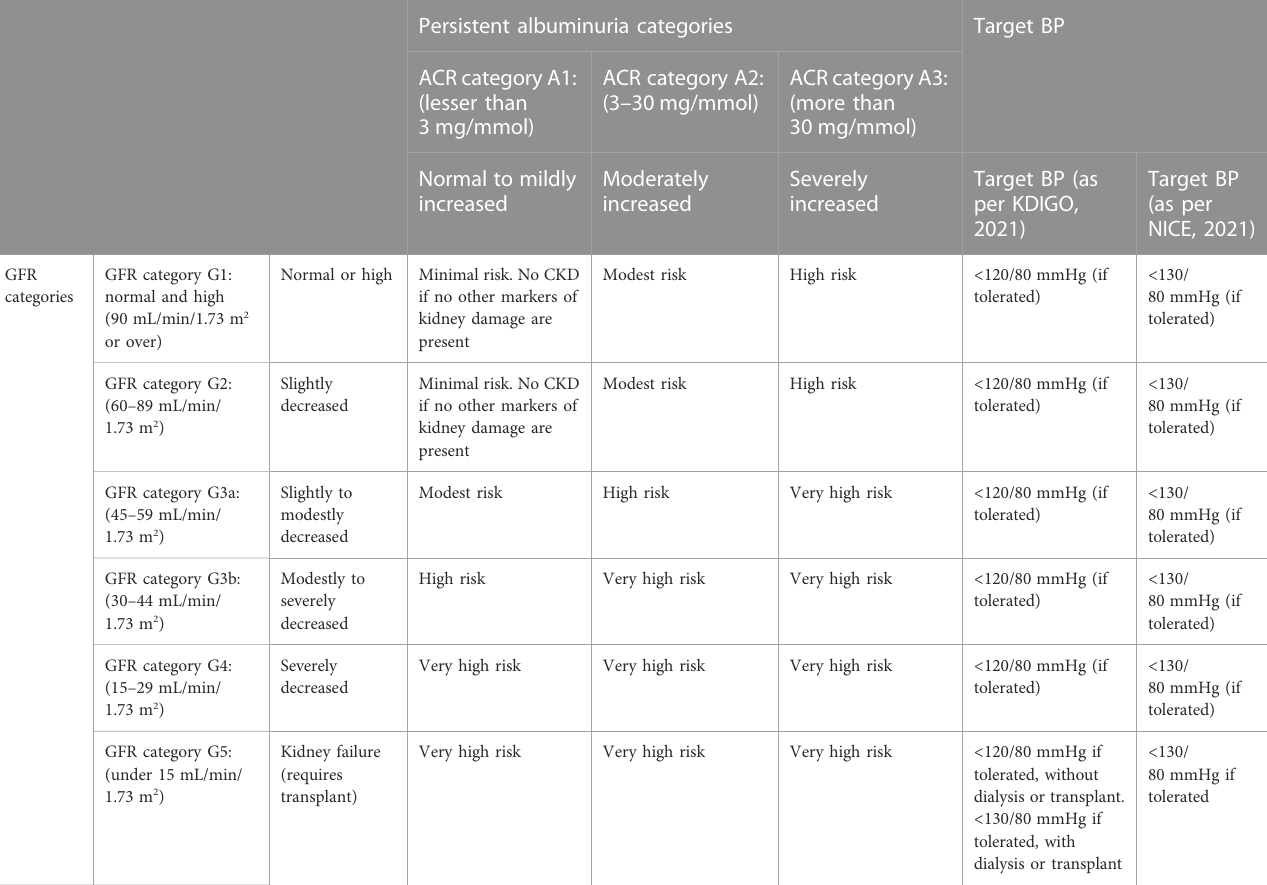
TABLE 1 Classi fi cation of CKD according to glomerular fi ltration rate (GFR), albuminuria category, and the target blood pressure as per NICE and